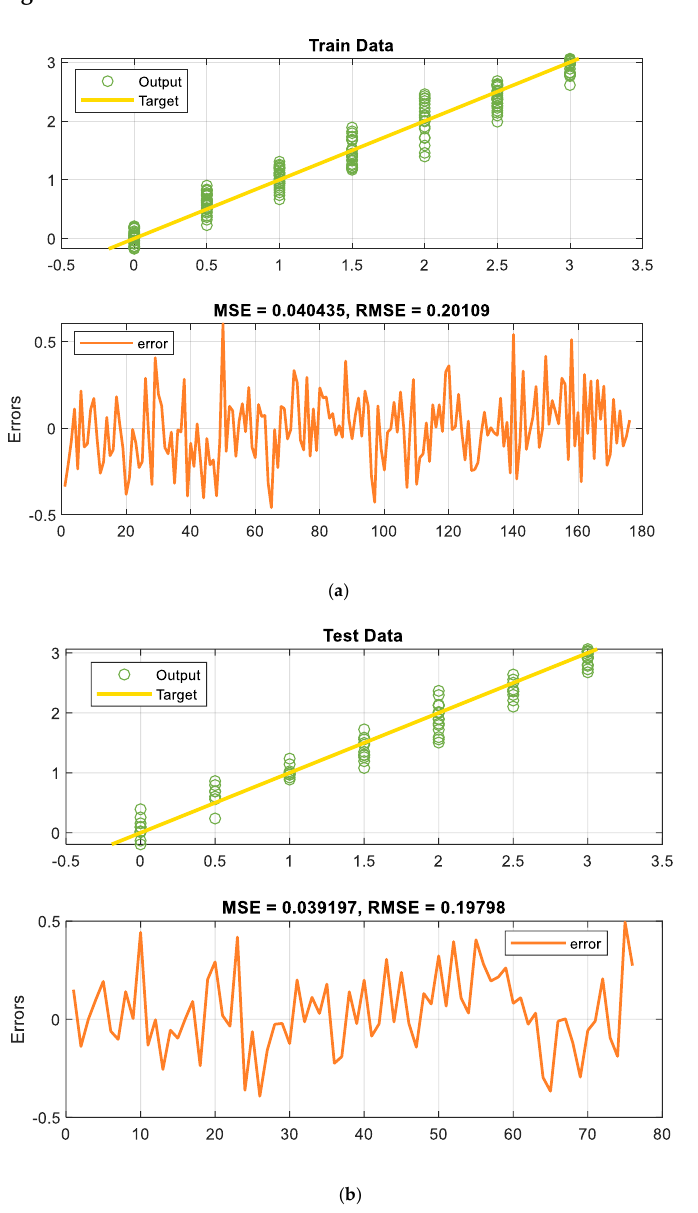
Figure 5. Performance of designed GMDH neural network against ( a ) training and ( b ) testing data.